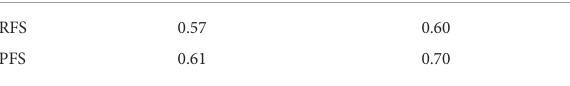
TABLE 4 Comparison of concordance index.